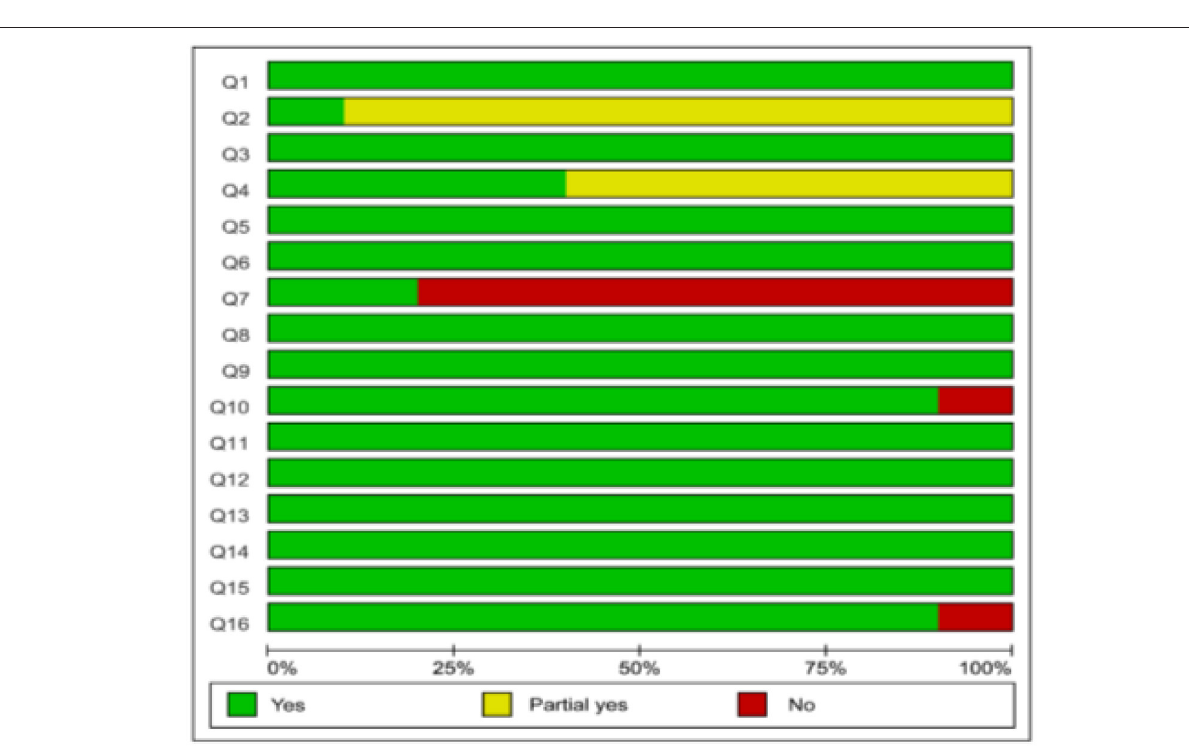
FIGURE 3 | Graphical representation of the